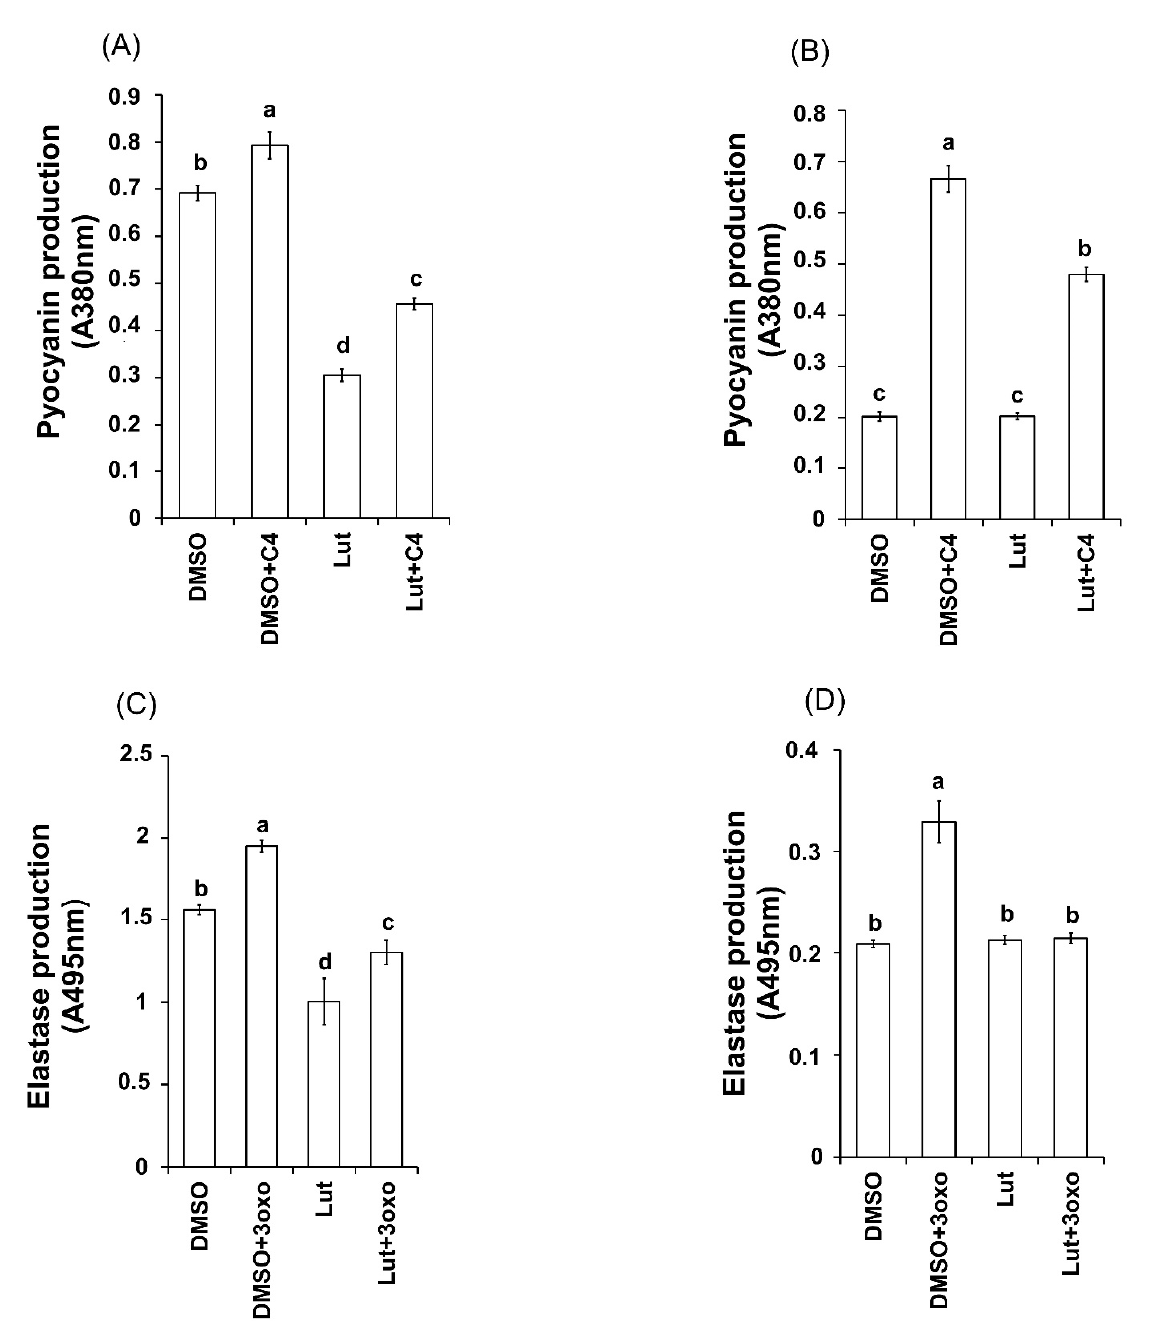
Figure 10. Effect of Lut on the production of pyocyanin and elastase after exogenous supply of AHLs in PAO1 wild-type and mutant strains. ( A – D ) Production of pyocyanin and elastase by the wild-type strain PAO1 and ∆ rhII ( ∆ PA3476), ∆ lasI ( ∆ PA1432) mutant strains. Pyocyanin was extracted and quantified by absorbance measurement at 380 nm. Elastase production was assessed via an elastolysis assay and calculated as the ratio between A 495 and A 600 . In each case, bacteria were incubated with DMSO, Lut or the appropriate AHL. Bacteria were also induced with the appropriate AHL and simultaneously treated with DMSO or Lut. C4-HSL (C4) and 3-oxo-C12-HSL (3oxo) were added at 10 µM final concentration. DMSO-treated cultures were used as controls, the statistical significance of each test (n = 4) was evaluated by conducting one-way ANOVA with Tukey’s multiple comparison tests, and a p -value of 0.01 was considered significant. Different letters (a, b, c and d) above the bars indicate data that are statistically different from each other ( p < 0.01).